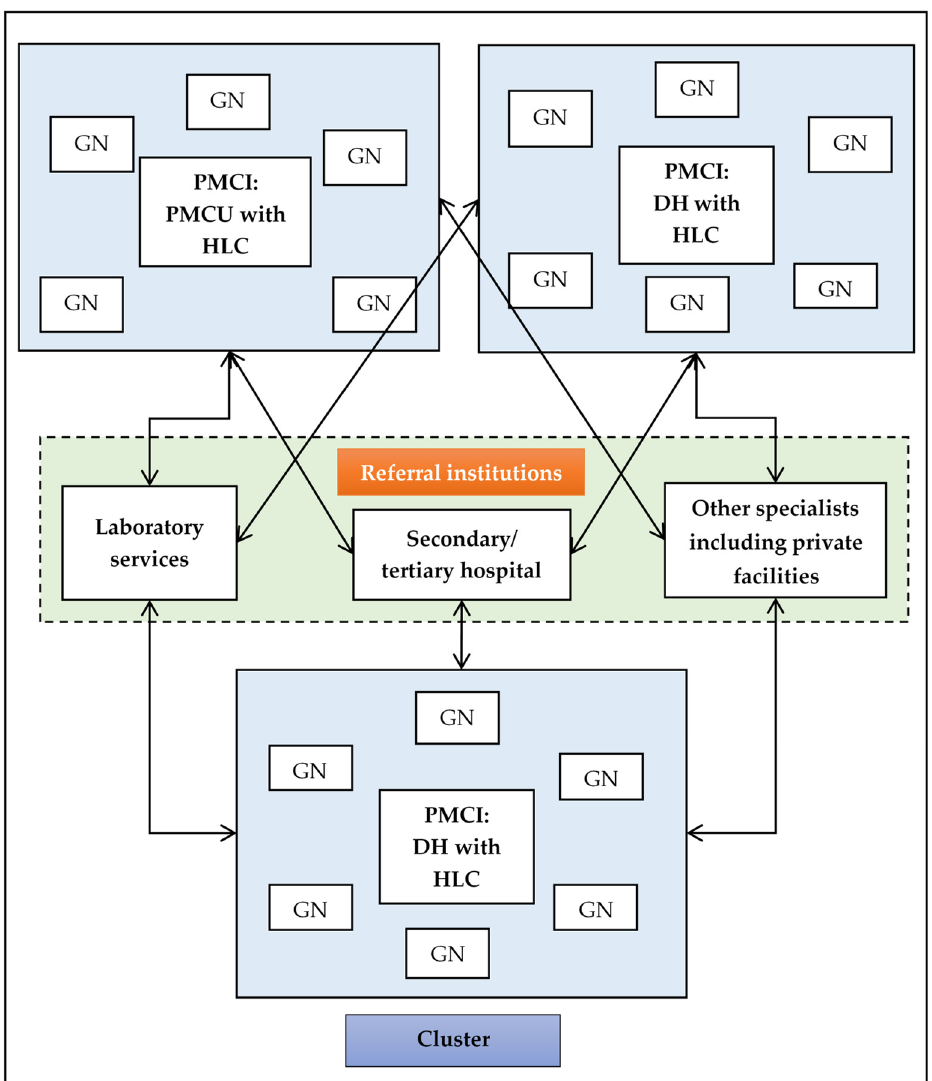
Figure 1. Schematic diagram representing identification of PMCI and cluster under the PSSP project. Abbreviation: DH = Division Hospital; DH-C: Division Hospital of Type-C; PMCI = Primary Medical Care Institution; GN = Grama Niladhari; PMCU = Primary Medical Care Unit; HLC = Health Lifestyle Centre.